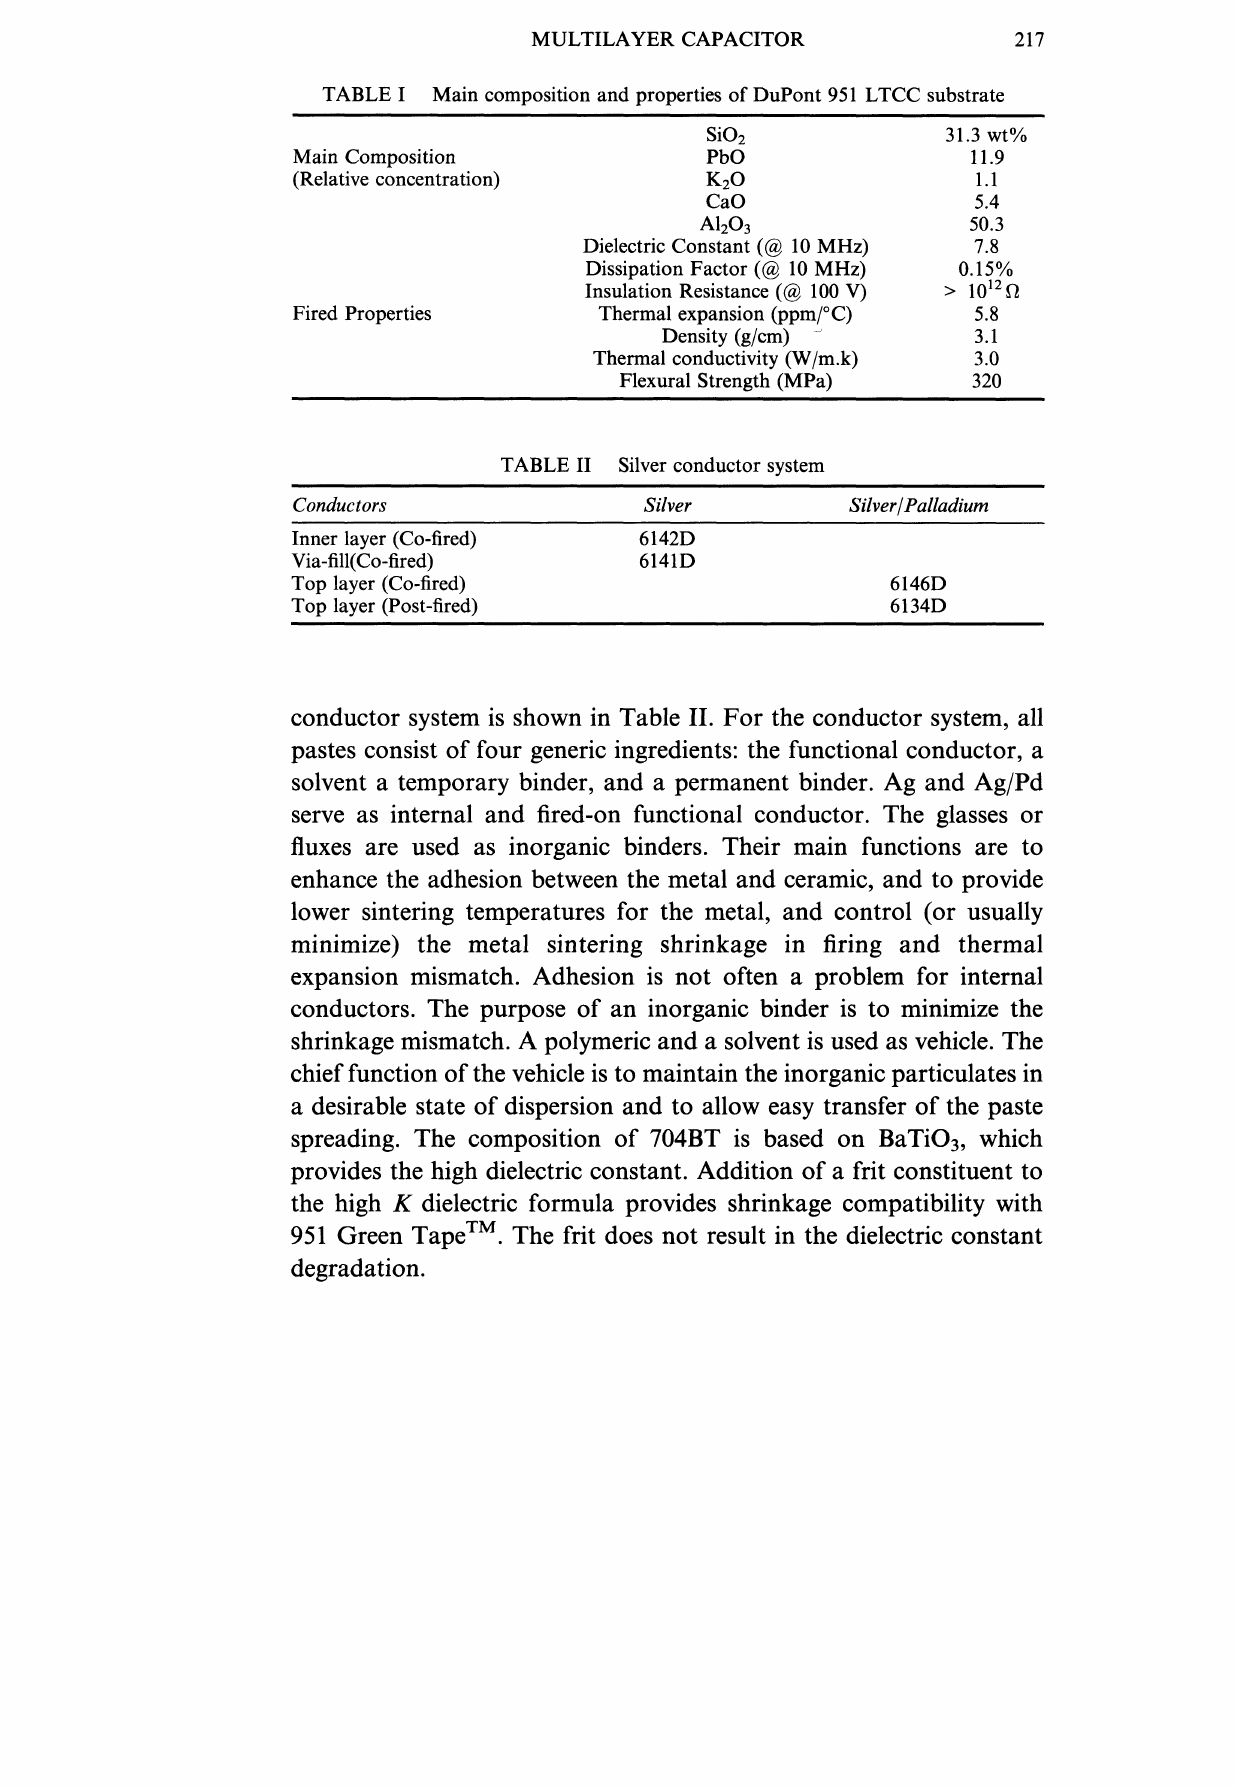
Main composition and properties of DuPont 951 LTCC substrate Main Composition (Relative concentration)